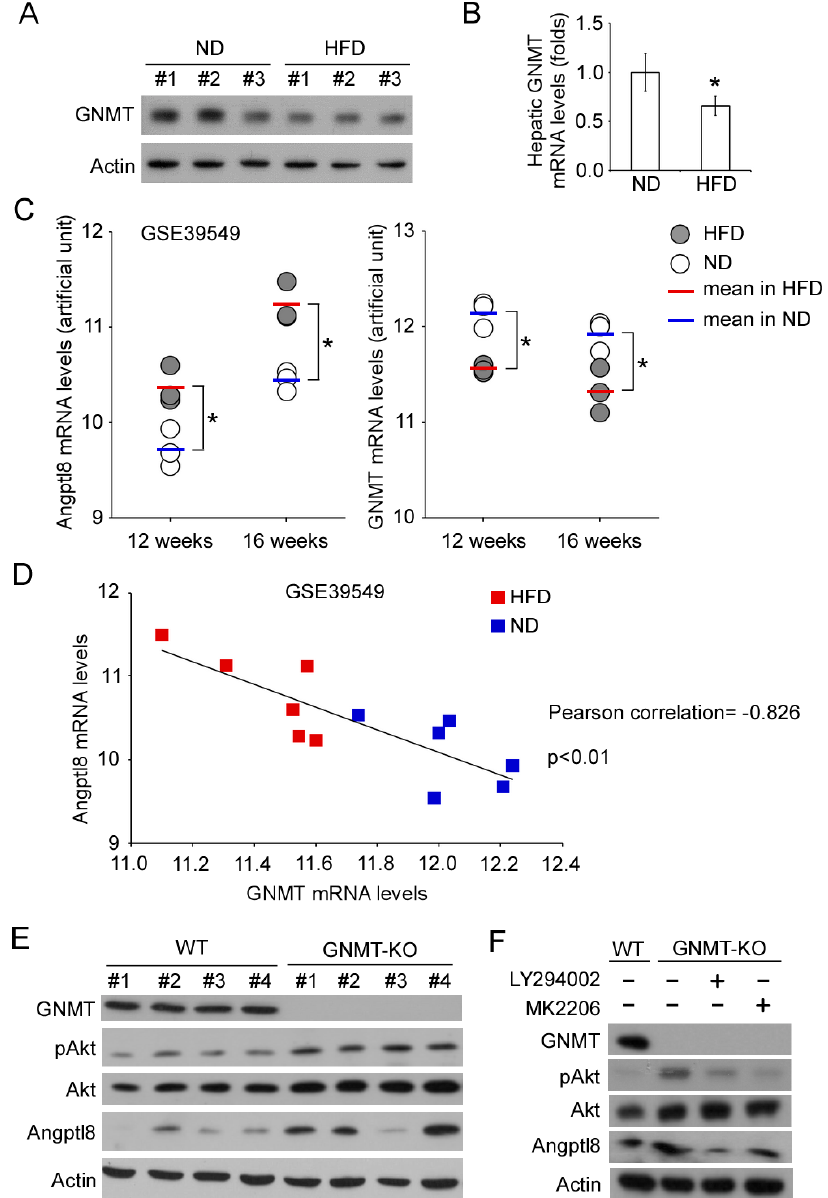
Figure 4. The inverse correlation of GNMT and Angptl8 expression in the livers of HFD-fed mice. ( A – B ) The expression of hepatic GNMT protein ( A ) and mRNA ( B ) in the HFD-fed and ND-fed mice was revealed by Western blot and qPCR respectively. ( C ) The data of Angptl8 and GNMT mRNA expression was extracted from a microarray dataset, GSE39549; * p < 0.05, compared between the HFD and ND groups. ( D ) The data of Angptl8 and GNMT mRNA levels for each mouse were plotted. The inverse correlation of Angptl8 and GNMT was confirmed by Pearson’s correlation; * p < 0.01. ( E ) The liver tissues were obtained from wild type and GNMT-KO mice. The expression of indicated proteins were examined by Western blot. ( F ) The primary culture of hepatocytes was established from wild type and GNMT-KO mice. The primary hepatocytes were treated with LY294002 or MK2206, and the expression of indicated proteins was determined by Western blot.